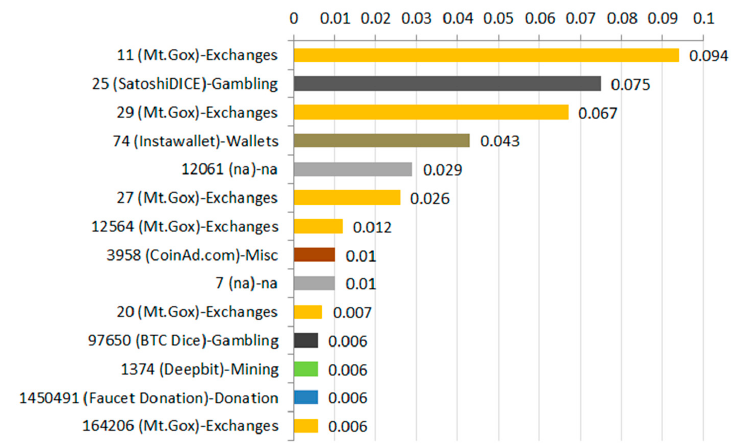
Figure 27. Degree Centrality in the Bitcoin Network (September 2012–April 2013).